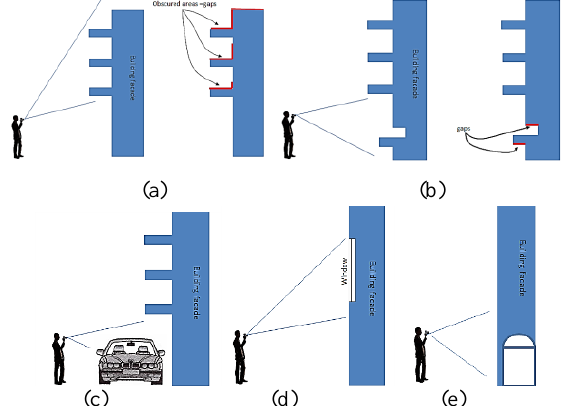
Figure 16. Gaps cause. (a) Obscured parts from street view. (b) Protrusions in facades. (c) Occlusion effect. (d) Texture-less parts. (e) Real